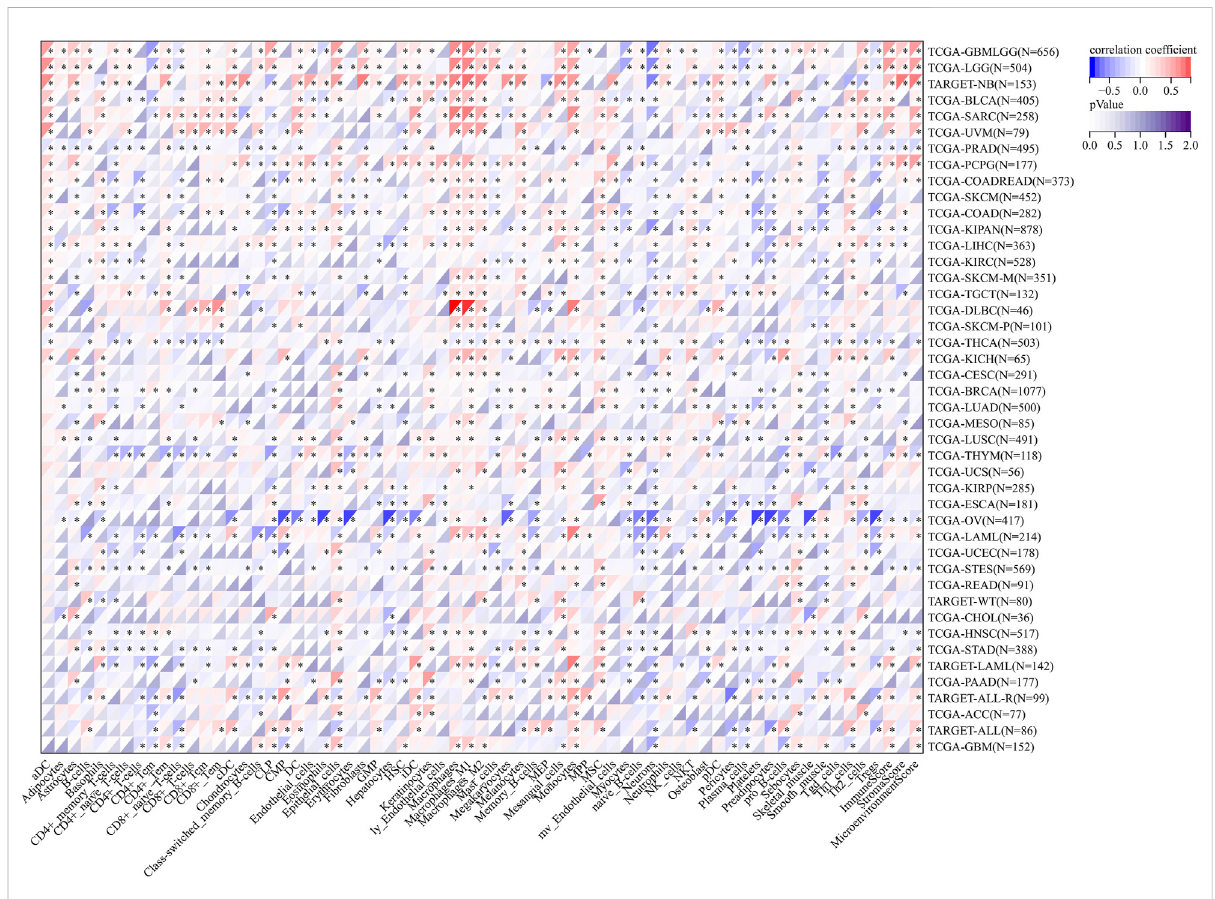
FIGURE 9 Analysis of correlation between the expression of AGTRAP and immune cell in fi ltration, ImmuneScore, StromaScore, and